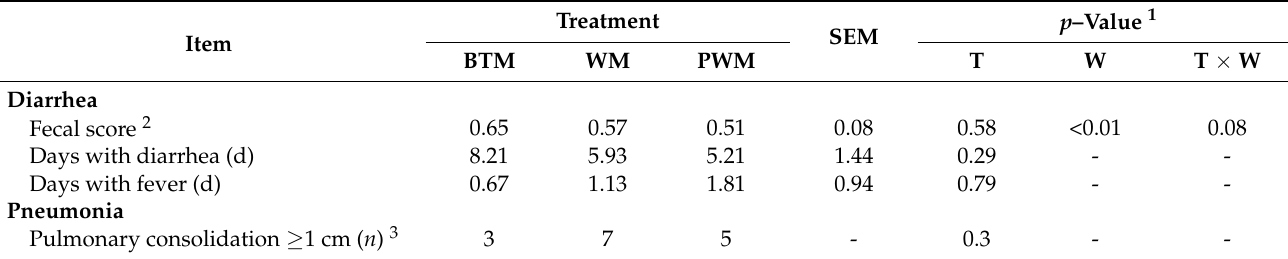
Table 4. Health parameters of dairy calves fed bulk tank milk (BTM, n = 15), waste milk (WM, n = 15), and pasteurized waste milk (PWM, n = 15) during the period from 4 to 60 d of